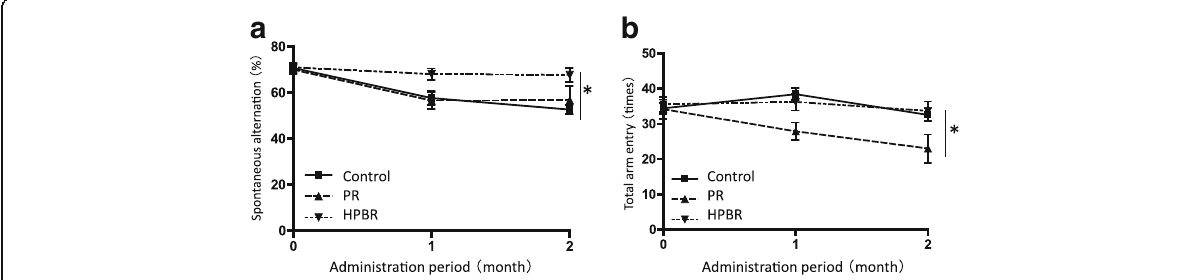
Fig. 3 Y-maze test. a Spontaneous alternation behavior rate. P = 0.009, two-way ANOVA, * P < 0.05, control vs. HPBR, Bonferroni post-test. b Total arm entry. P = 0.04, two-way ANOVA, * P < 0.05, PR vs. HPBR or control, Bonferroni post-test. PR: Polished rice, HPBR: highly water pressurized